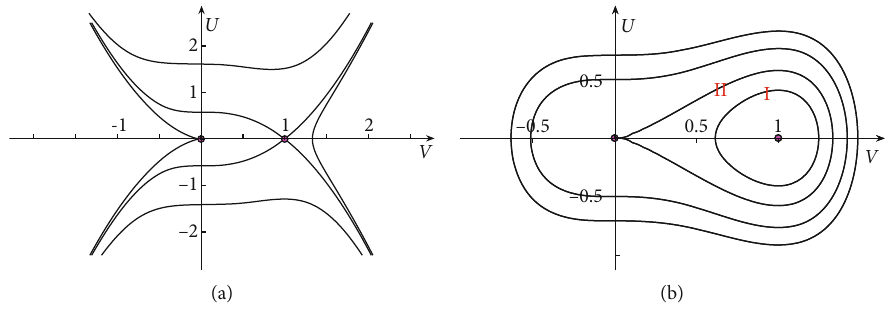
= 1 and (b) a = − 1 . 4 4